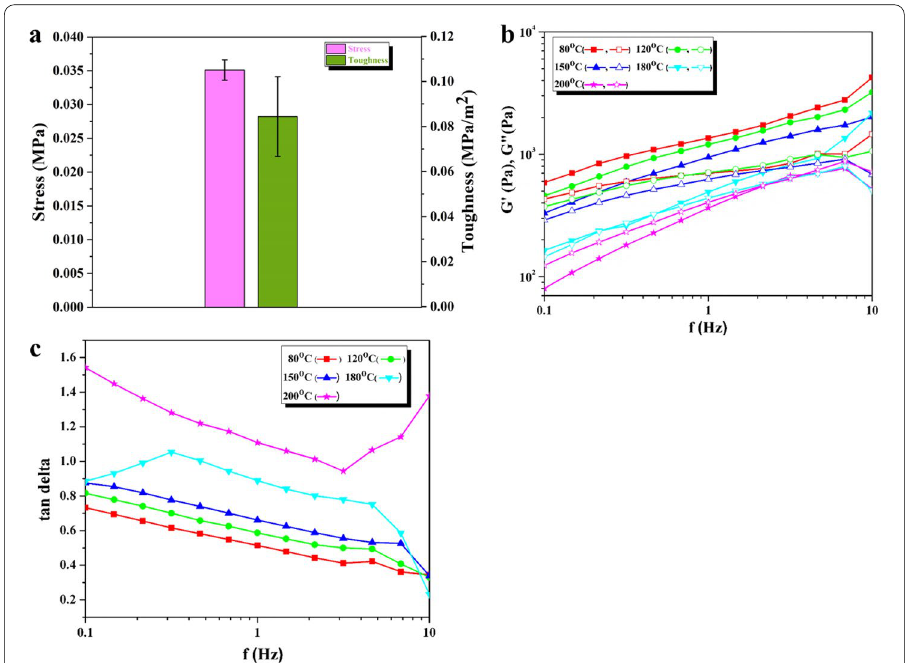
Fig. 3 a stress at break and toughness of P n BA- g -PAN; b Storage modulus (G’, solid symbols) and loss modulus (G’’, hollow symbols) for P n BA- g -PAN graft copolymer elastomer as a function of frequency